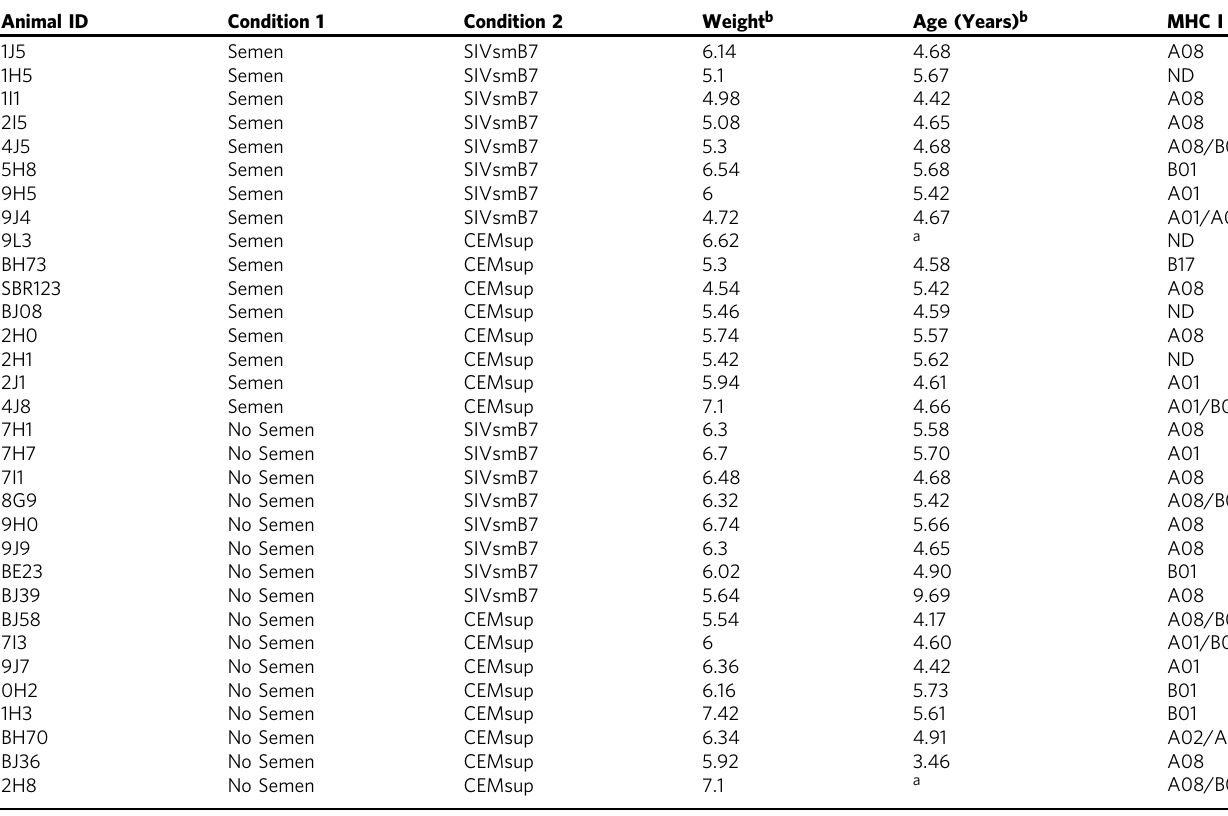
Table 1 Biological data for animals used in low-dose SIVmac251 Challenge Study Animal ID Condition